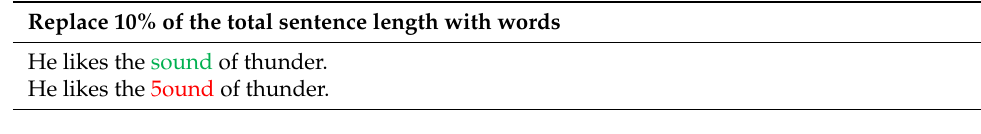
Table 2. Adversarial examples of